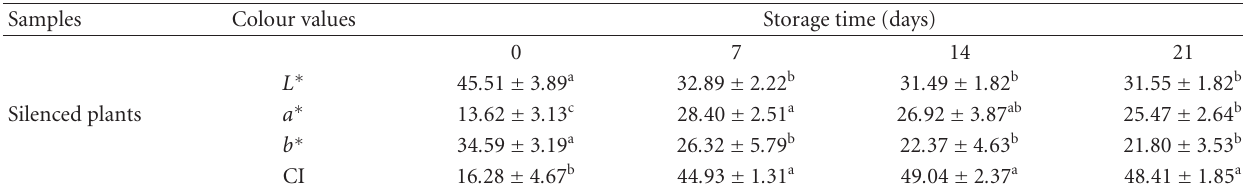
Table 3: Colour data for tomato silenced (Money Maker) at 7, 14, and 21 days of storage. Samples